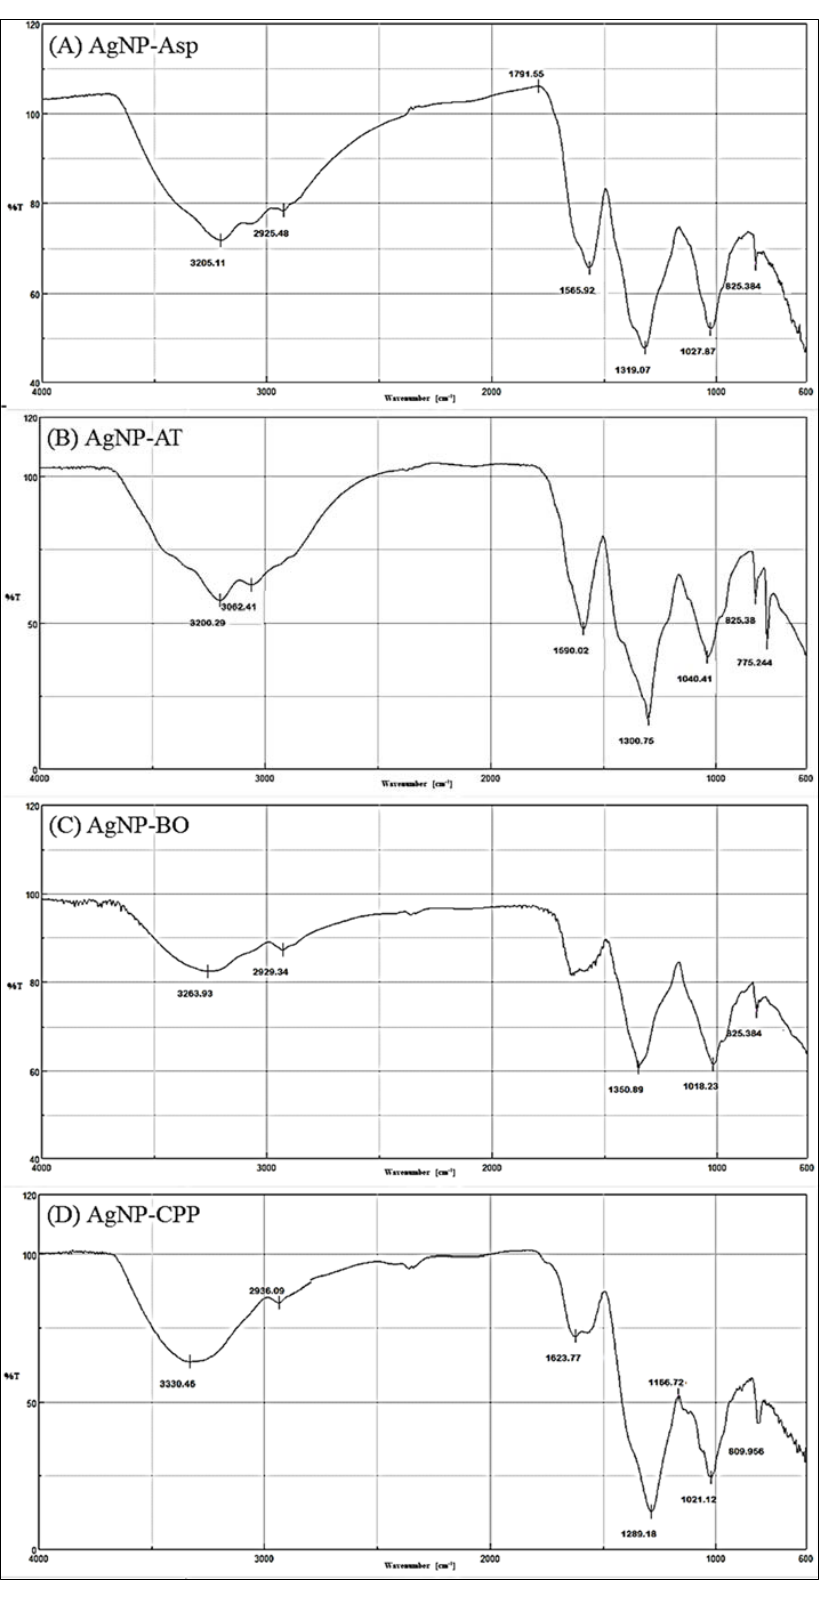
Figure 4. Fourier-transform infrared (FTIR) spectroscopy profile for the ( A ) AgNP-Asp, ( B ) AgNP-AT ( C ) AgNP-BO, and ( D ) AgNP-CPP.